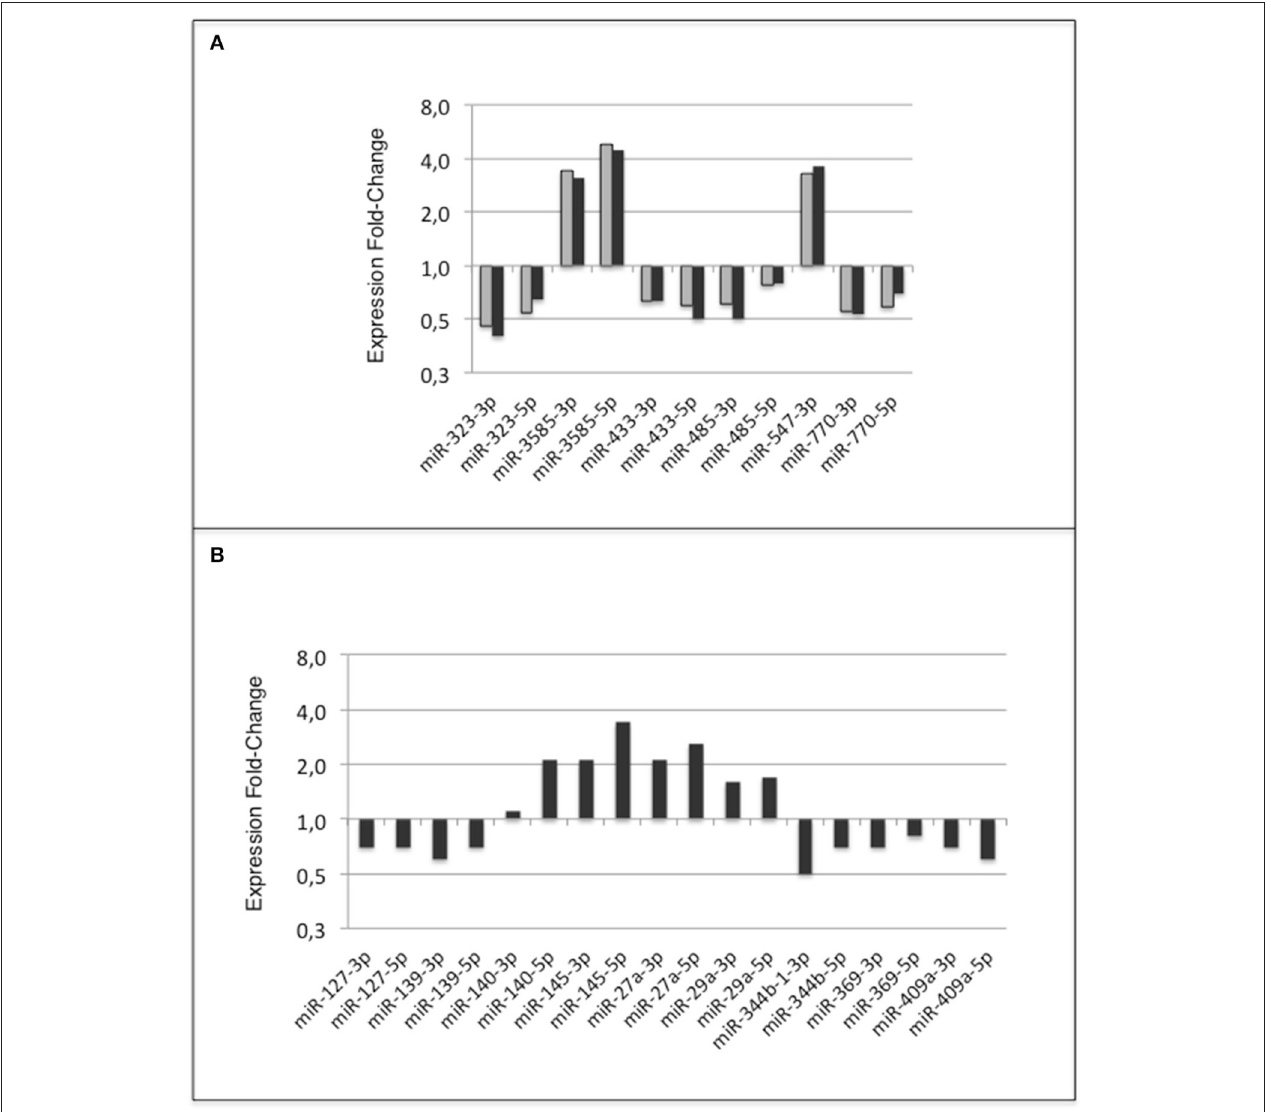
FIGURE 10 | miRNA response of adult ARC to metabolic environment. Summary (A) miRNA response to early metabolic challenge. Fold-Changes of Expression (FCE) were observed in Groups HF-C vs. C-C (gray bars) and Groups HF-HF vs. C-C (black bars); (B) Additional miRNA response to consecutive adult metabolic challenge observed in Groups HF-HF relatively to C-C. FCEs are shown using a log 2 scale.